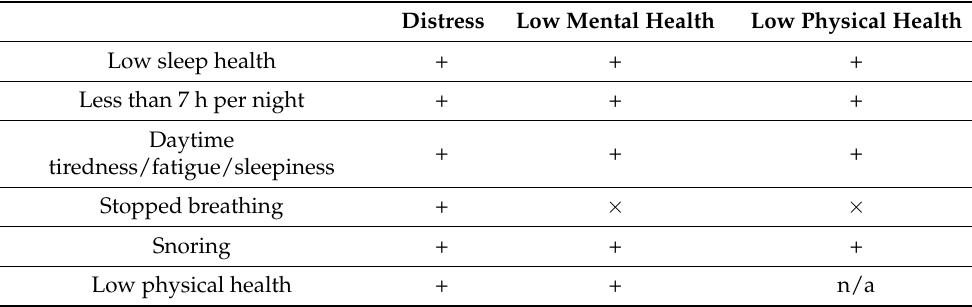
Table 5. Cumulative results on the association between sleep health, mental health, physical health, and academic performance. Distress Low Mental Health Low Physical Health Low sleep health